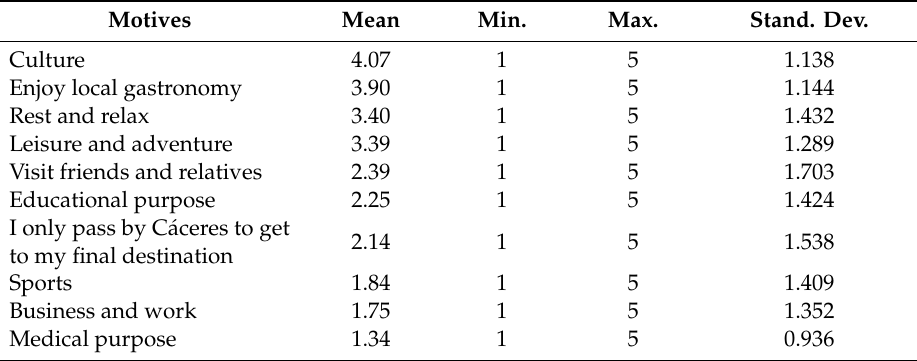
Table 5. Motivations for traveling to C á ceres.